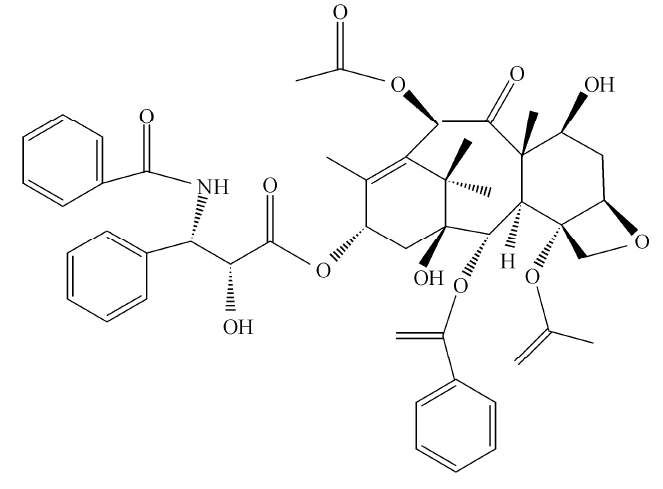
Figure 3. The structure of taxol.